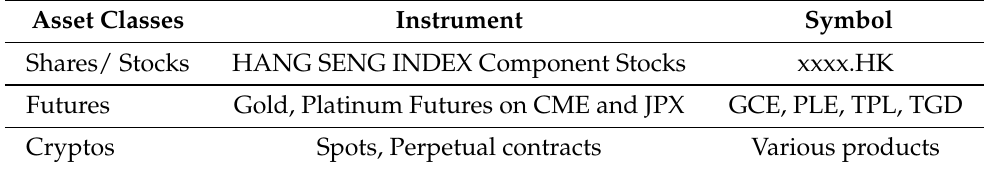
Table 2. We systematically examined the multiple asset classes, including shares (HSI Composite Stocks), futures (Gold, Platinum Futures on CME and JPX) and cryptos (Spot, Perpetual contracts). The data was purchased directly from the exchanges and was of the highest